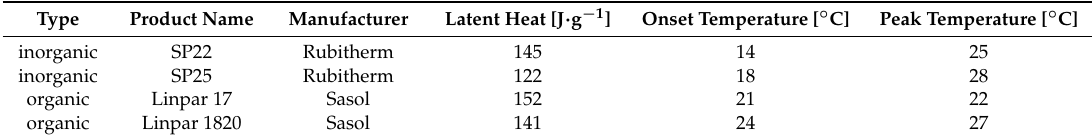
Table 2. Parameters of selected PCMs (measured during melting).